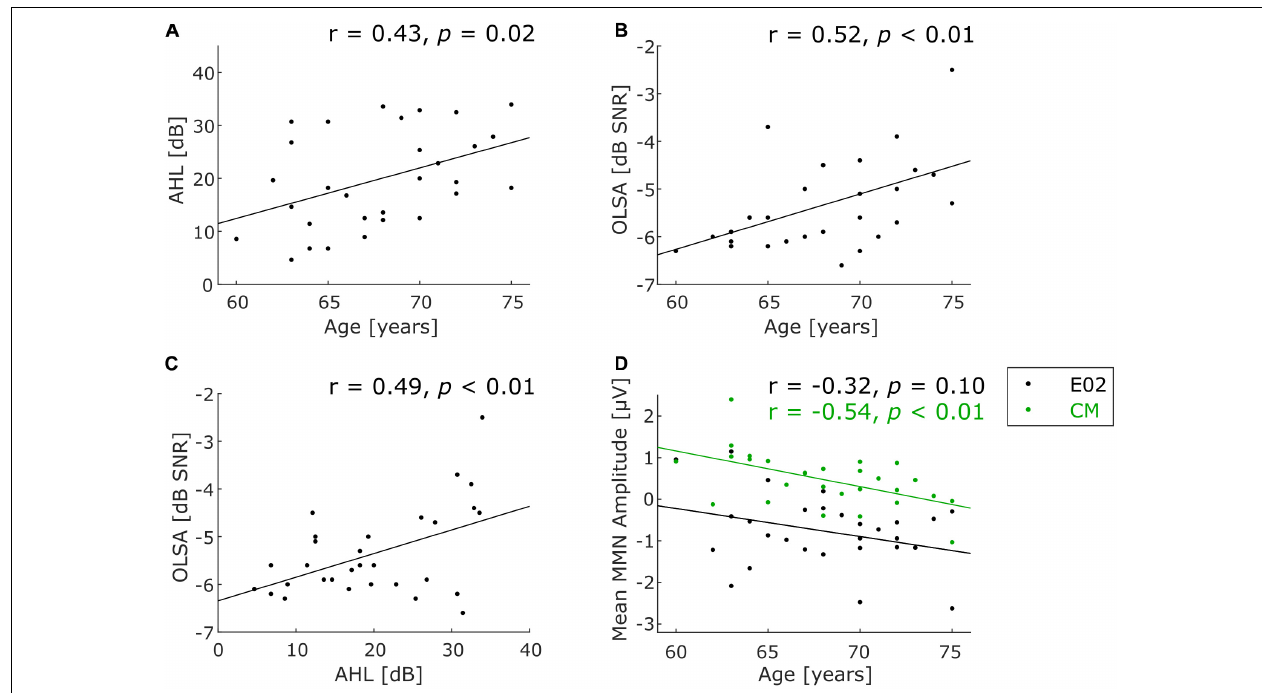
FIGURE 2 | Scatterplots for characterizing the participant sample. (A) Correlation of age and peripheral hearing status, (B) correlation of age and speech-in-noise comprehension, (C) correlation of the hearing tests with one another, (D) correlation of age and deviance detection measured by MMN at frontocentral electrode position (E02, black dots) and common mastoids (CM, green dots). Note that only 28 participants were included for the latter correlation (see text for details). Significantly positive correlations indicate that higher age is associated with higher average hearing loss ( A , p = 0.02) and with worse speech-in-noise comprehension ( B , p < 0.01). Moreover, higher average hearing loss is associated with worse speech-in-noise comprehension ( C , p < 0.01). A significant negative correlation between MMN amplitude and age only for CM shows less positive amplitudes with increasing age ( D , green line, p < 0.01).